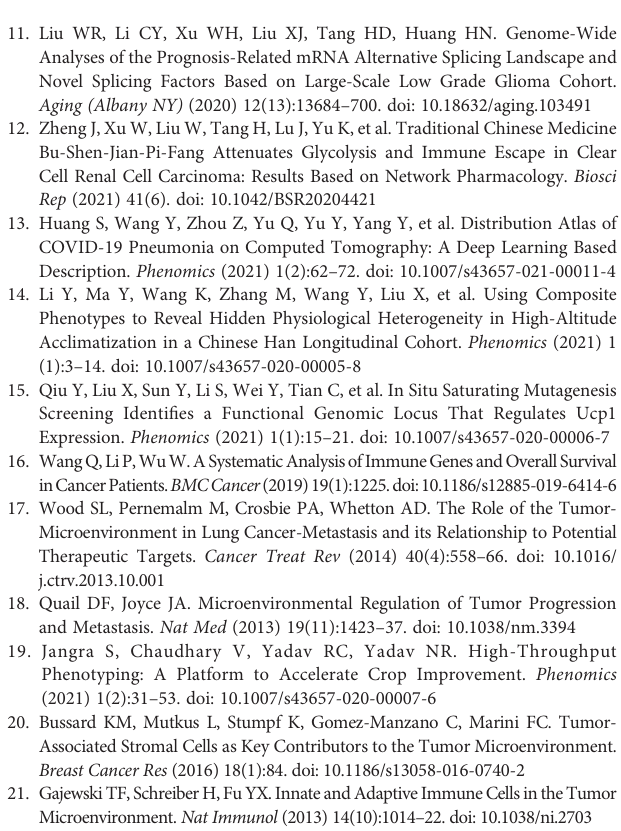
Supplementary Figure 1 | The relationship between CD3E expression and survival of UVM patients was shown. Supplementary Figure 2 | The differential expression of cd3e was investigated according to the histological subtypes of LGG. The expression of CD3E in astrocytoma (n = 194) was signi fi cantly higher than that in oligoastrocytoma (n = 130, P = 6.436000e-04) or oligodendroglioma (n = 130, P = 6.418700e-04). Supplementary Figure 3 | A subgroup analysis of different clinical characteristics on clinical data to eliminate clinical bias was performed. Supplementary Figure 4 | Relations between abundance of tumor-in fi ltrating lymphocytes and expression, copy number, methylation, or mutation of CD3E . Supplementary Figure 5 | The relationship between the abundance of tumor in fi ltrating lymphocytes and the expression, copy number, and methylation or mutation of CD3E in LGG was analyzed. Supplementary Figure 6 | TIDE algorithm to study the effect of CD3E on LGG patients receiving immune checkpoint inhibitor therapy. Supplementary Figure 7 | The expression distribution of CD3E gene in different tumor tissues was shown. The horizontal axis represented different groups of samples, and the vertical axis represented the expression distribution of the